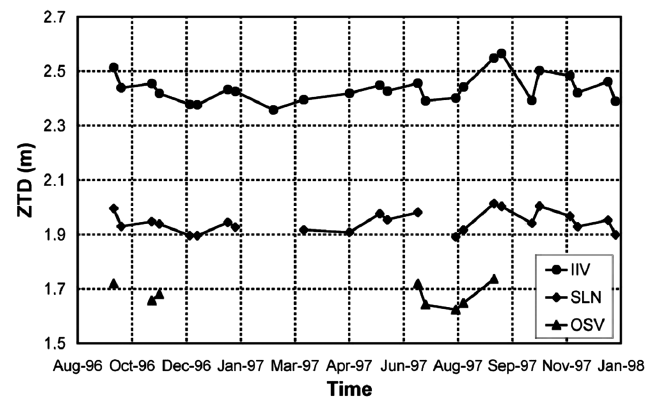
Fig. 2. ZTD values corresponding to each Etnean site and session, at the time of ERS-2 passes over Mt. Etna (21:16 and 09:41 respectively for ascending and descending passes).